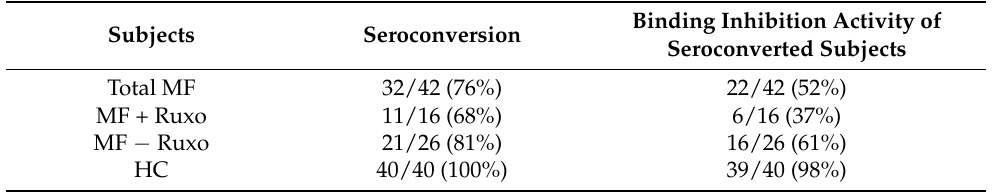
Table 2. Number and percentage (in bracket) of patients with seroconversion and binding inhibition activity detected within MF patients (MF + Ruxo and MF-Ruxo) and HC